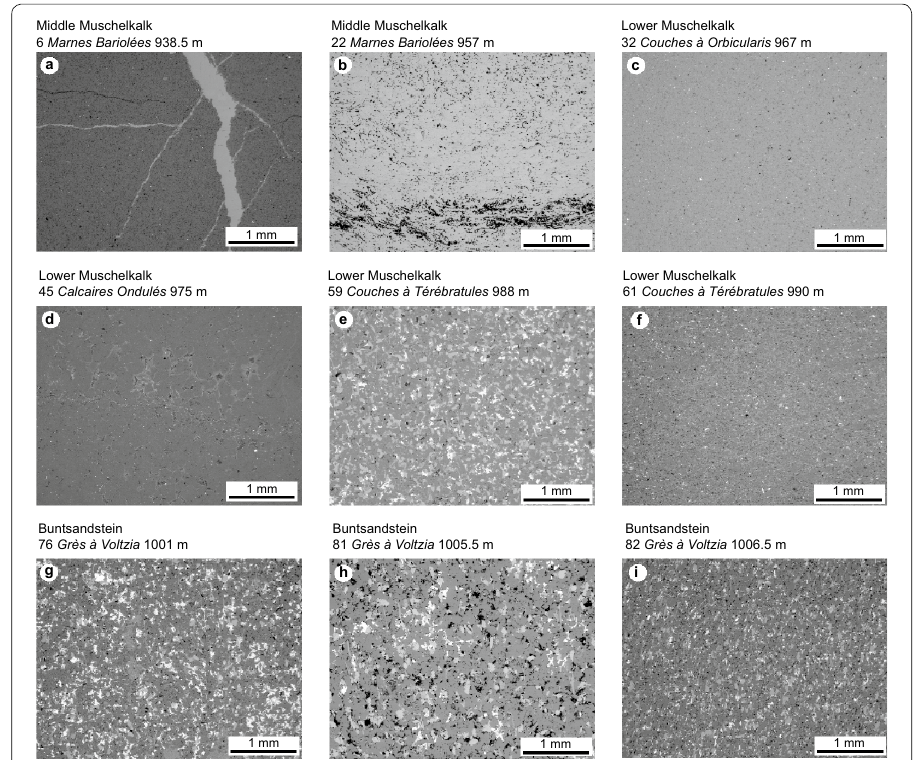
Fig. 4 Backscattered scanning electron microscope images showing the microstructure of the six Muschelkalk samples chosen to represent the variability of the Muschelkalk at exploration well EPS-1 (Soultz-sous-Forêts) ( a – f ), and three samples from the Buntsandstein at the Muschelkalk–Buntsandstein interface ( g – i ). The lithological unit, box number, and measured depth are given next to each